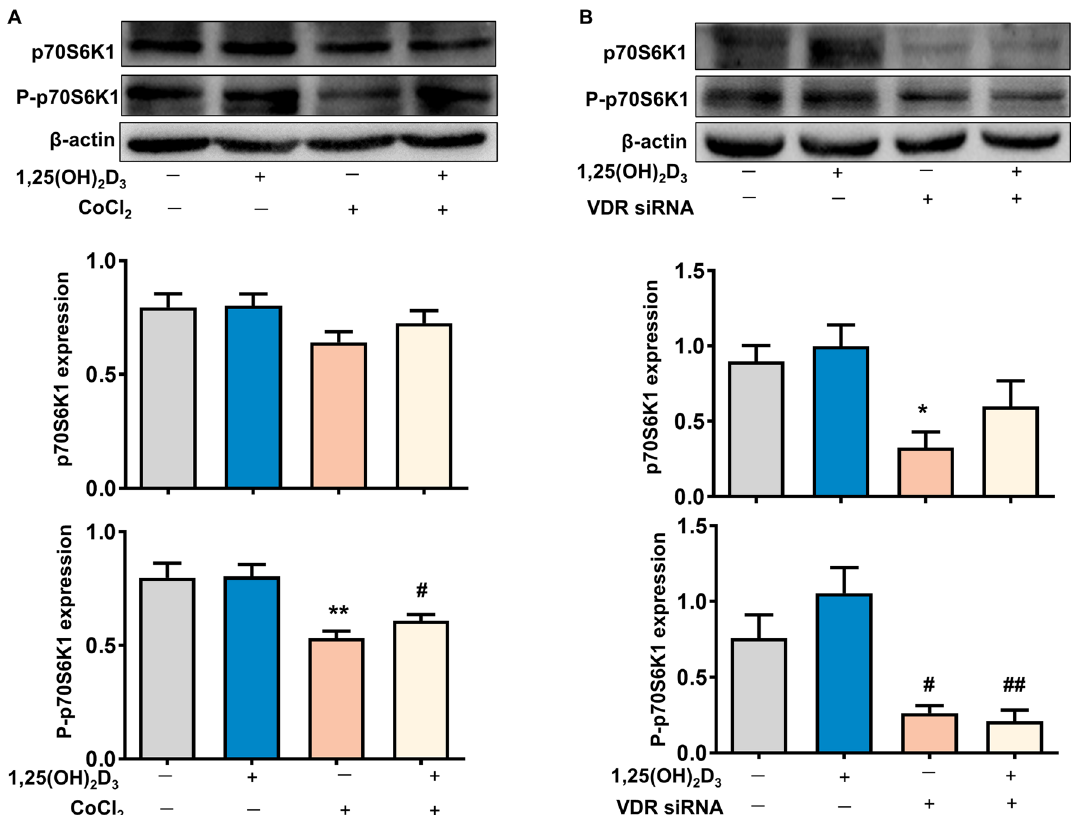
Figure 4. Effects of 1,25(OH) 2 D 3 on altered mTOR activity induced by CoCl 2 in placental trophoblasts. ( A ) Protein expression for p70S6K1 and P-p70S6K1 in HTR-8/SVneo trophoblast cells treated with CoCl 2 in the presence or absence of 1,25(OH) 2 D 3 . p70S6K1 is one downstream indicator of mTOR signaling activity, 1,25(OH) 2 D 3 prevented CoCl 2 -induced decrease of P-p70S6K1 expression in trophoblasts. The bar graphs show relative expression of p70S6K1 and P-p70S6K1 after being normalized by β-actin in each sample from six independent experiments. **P < 0.01, CoCl 2 treated vs control; # P < 0.05, 1,25(OH) 2 D 3 + CoCl 2 vs CoCl 2 alone. ( B ) Protein expression for p70S6K1 and P-p70S6K1 in HTR-8/SVneo trophoblast cells treated with VDR siRNA in the presence or absence of 1,25(OH) 2 D 3 . Inhibition of VDR expression markedly suppressed P-p70S6K1 and total p70S6K1 expression in trophoblasts. The bar graphs show relative expression of p70S6K1 and P-p70S6K1 after being normalized by β-actin in each sample. Data are from four independent experiments. *P < 0.05, VDR siRNA vs control; # P < 0.05, ## P < 0.01, treated vs 1,25(OH) 2 D 3 alone.